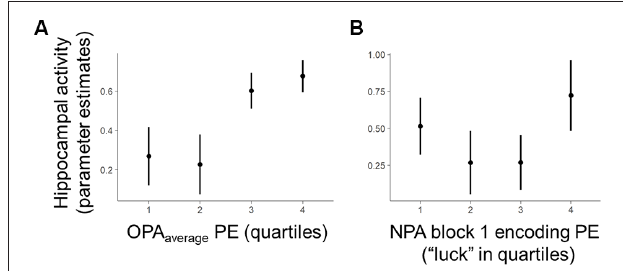
FIGURE 5 | Within-subject relationship between OPA performance and hippocampal activity. Quartiles reflect within-subject binning of environment-by-environment measures into quartiles for visualization purposes only (LME analyses used continuous performance differences across each environment). (A) Within the hippocampus, there was a negative relationship between planning activity and OPA average performance that significantly interacted with “luck” during initial NPA encoding. (B) Controlling for the effect of Lucky Shots, when participants had better OPA average performance and encountered the NPA location quickly during NPA block 1, they recruited the hippocampus and its subdivisions less on NPA block 2 when planning navigation to the NPA